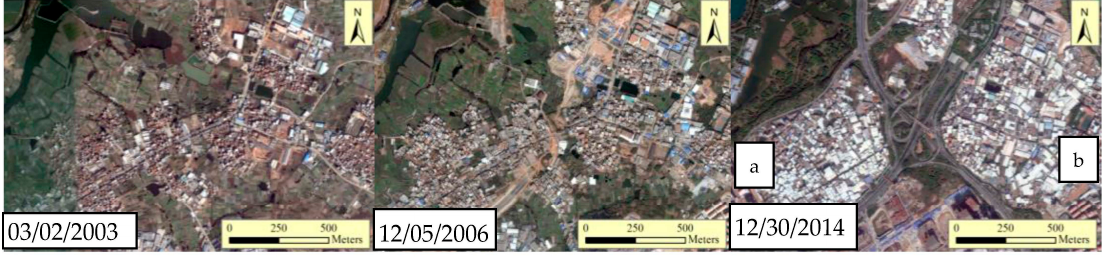
Figure 4. Increase of white tin roofs in two urban villages, Gaolin ( a ) and Wutong ( b ) of Xiamen island, obtained from Google Earth from 2003 to 2014.